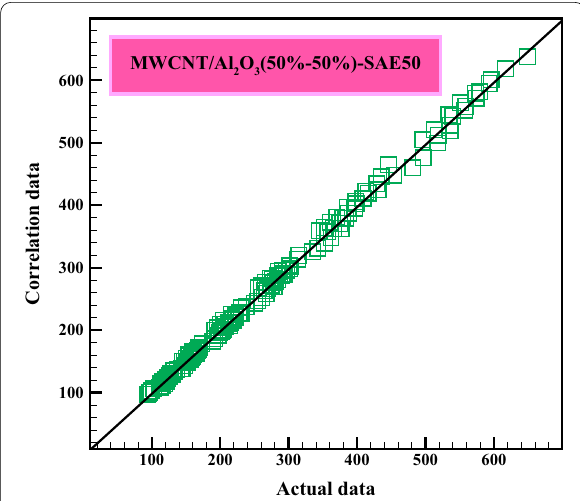
Fig. 13 Range of MOD values in all laboratory